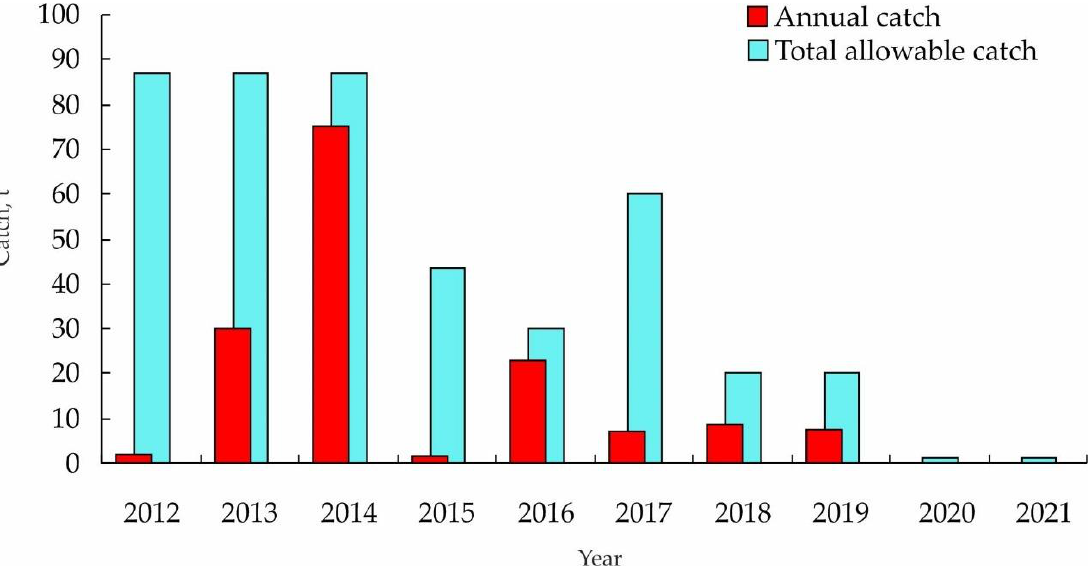
Figure 4. Total annual catch of Mizuhopecten yessoensis in Russian waters of the Sea of Japan (Pri- morye) [69,70].